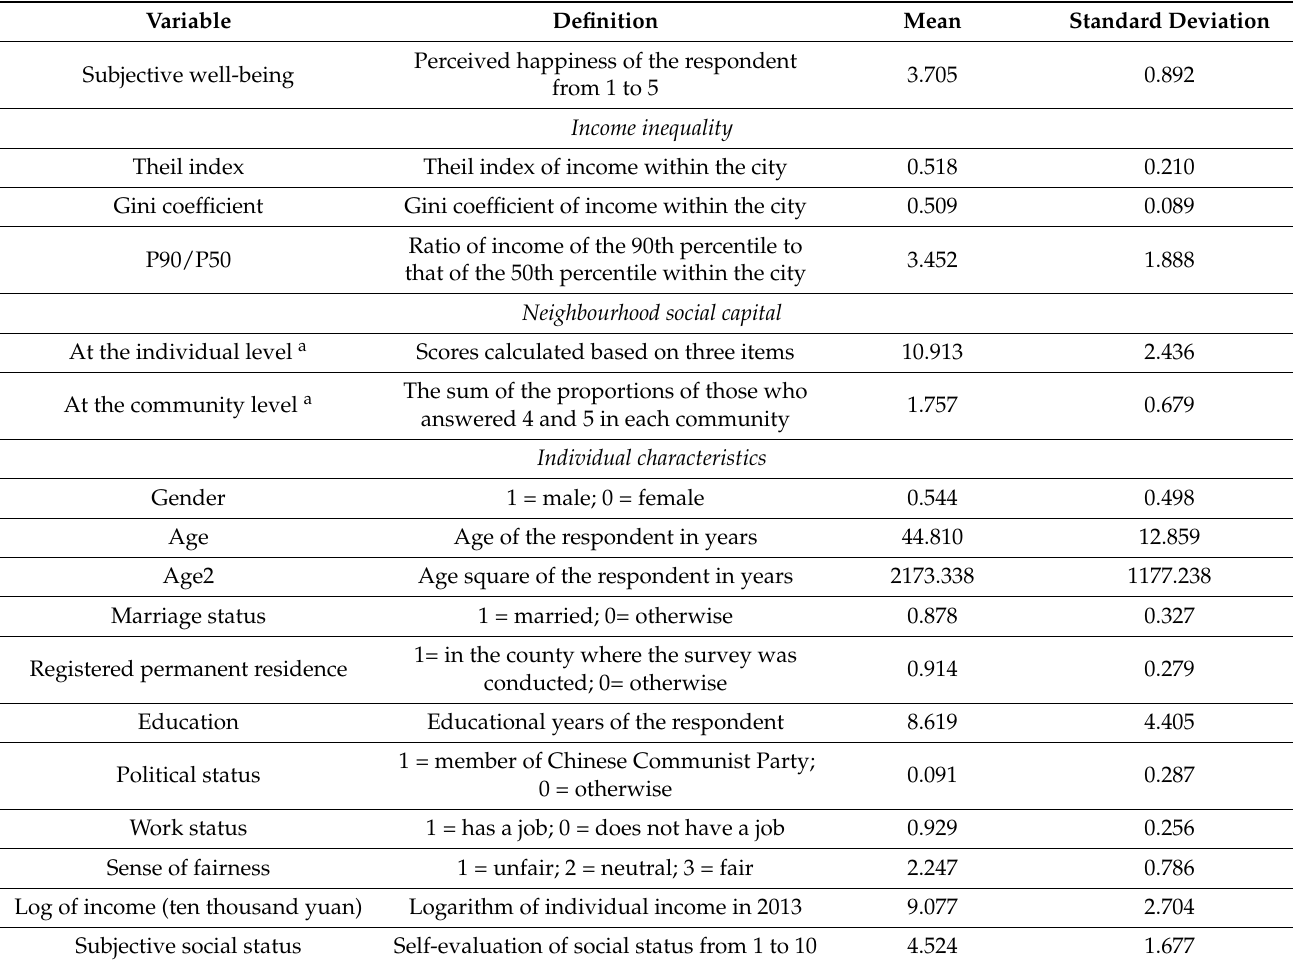
Table 2. Descriptive